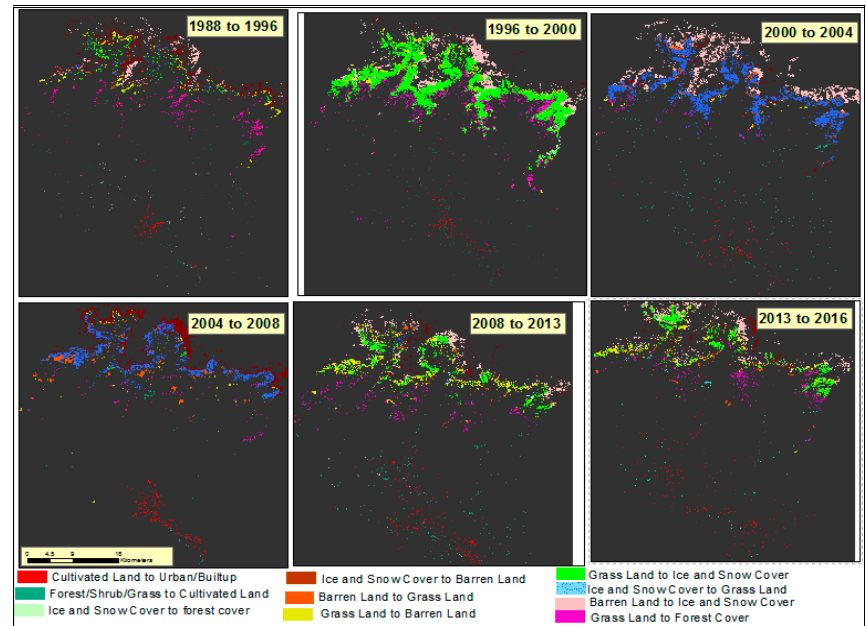
Figure 5. LULC transition map for six time periods.